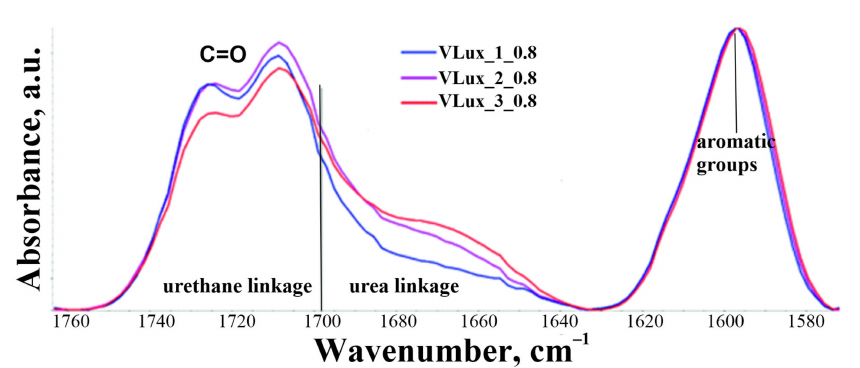
Figure 4. Comparison of ATR-FTIR spectra in the range 1760–1580 cm − 1 for foams with different water content at INCO = 0.8.